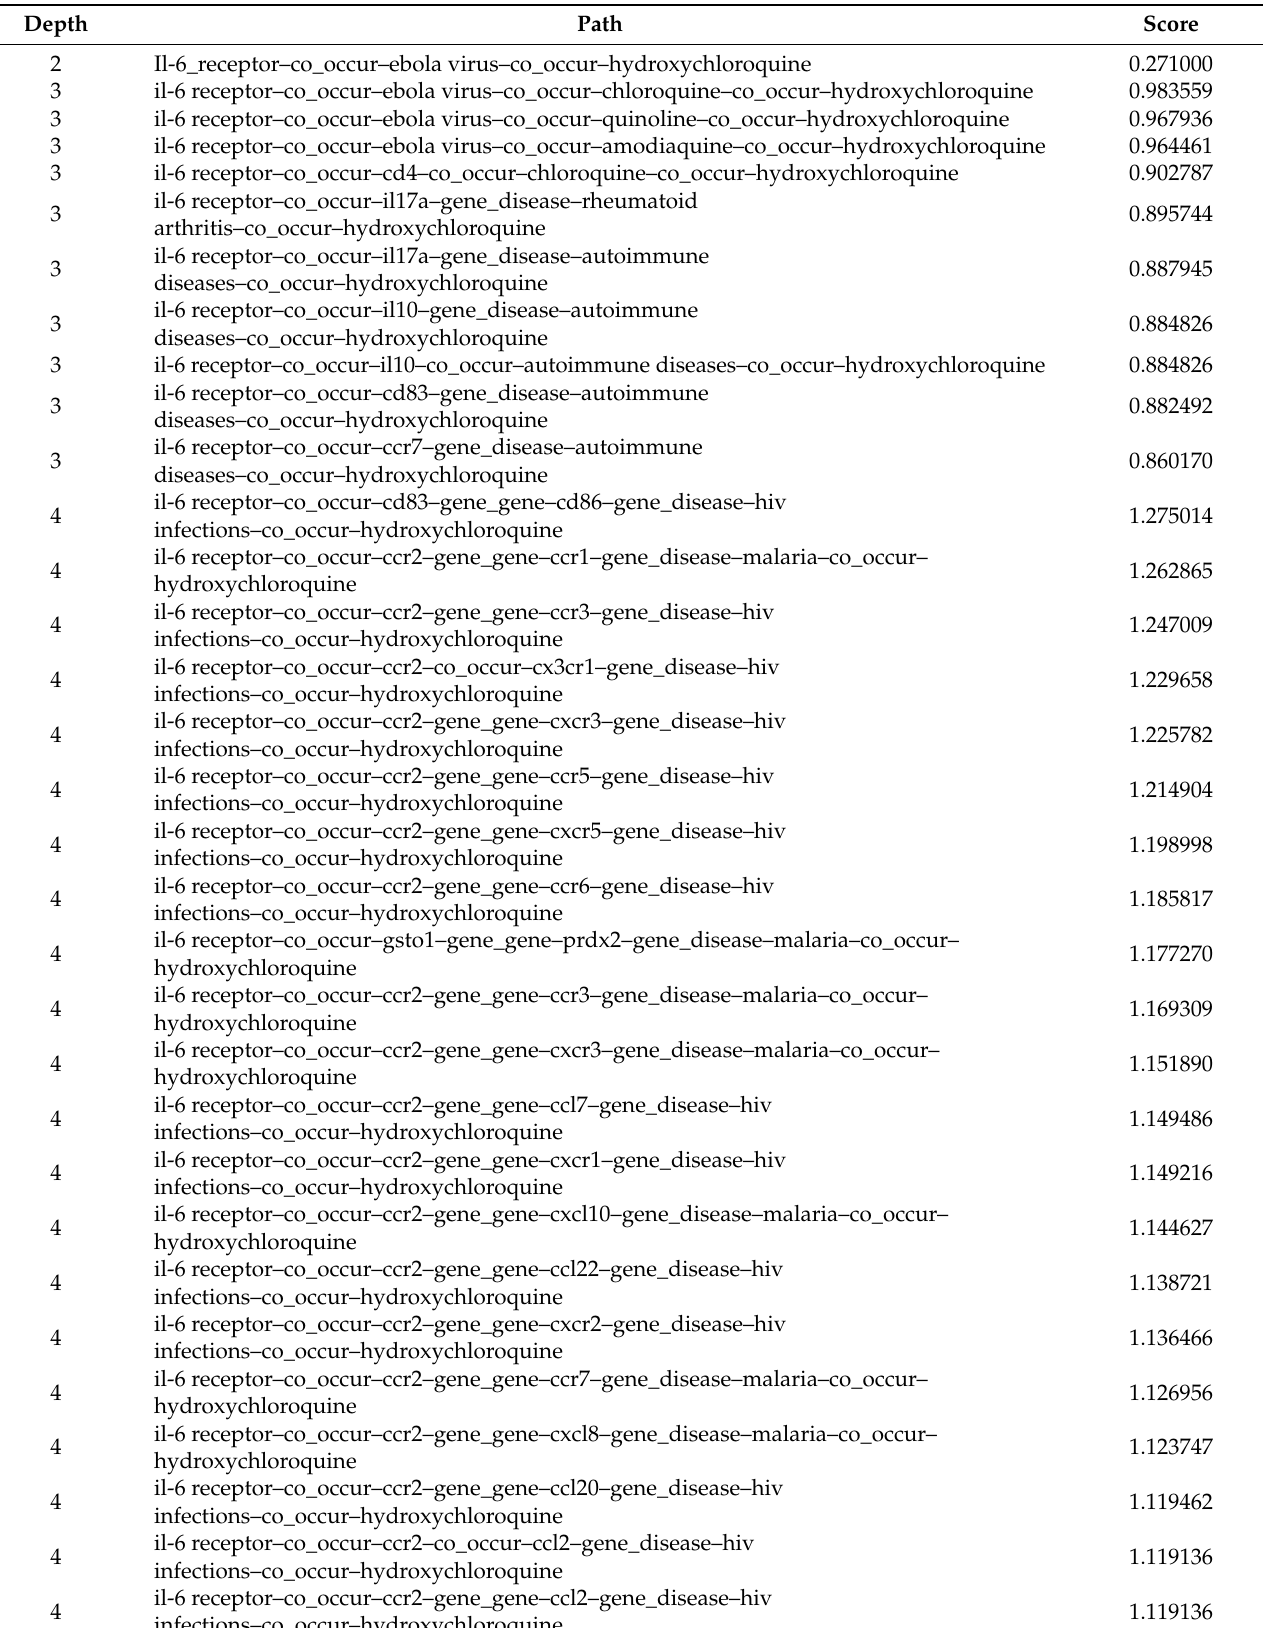
Table 7. Top-ranked paths from IL-6 receptor to